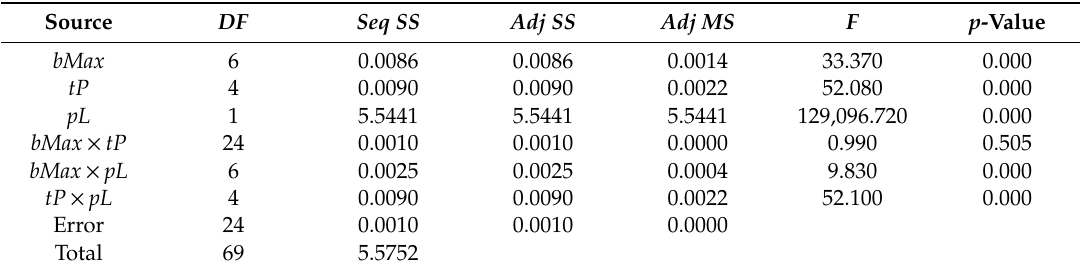
Table 2. ANOVA results for parameters of VBIH.